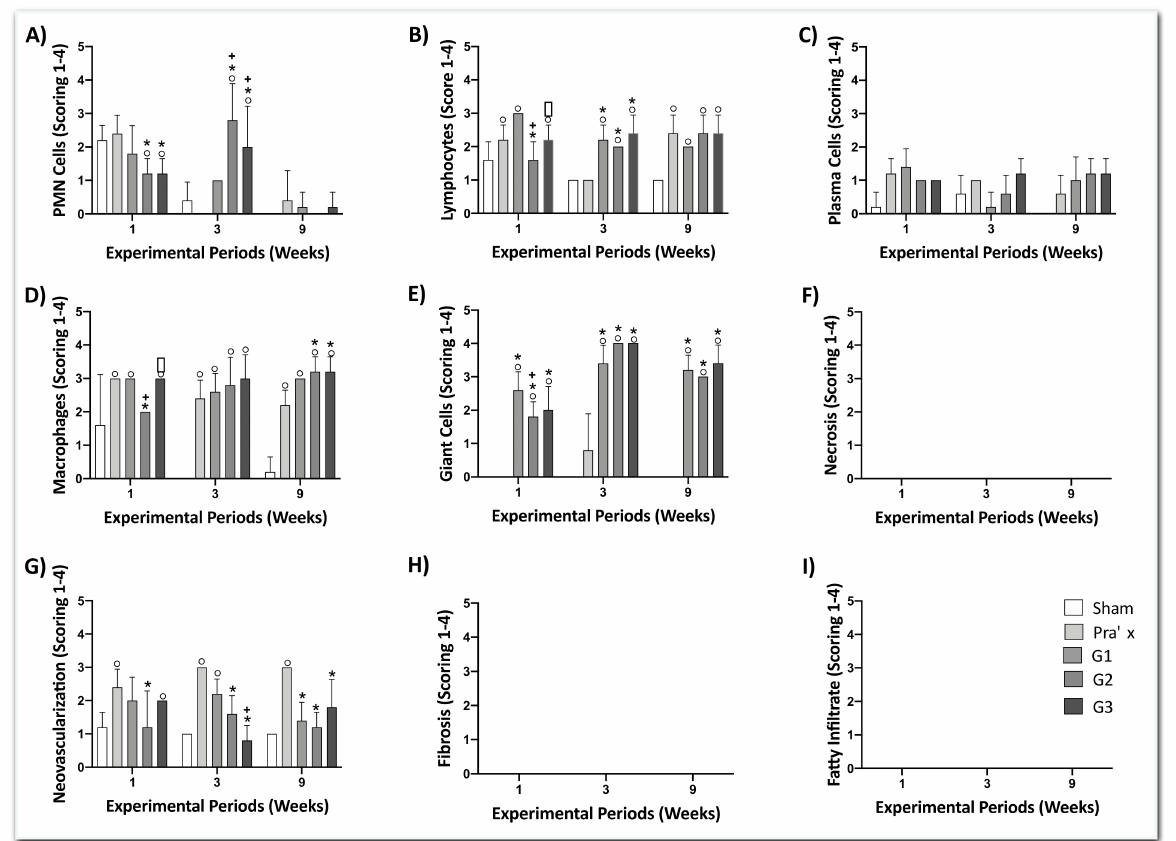
Figure 10. Inflammatory cells response ( A – E ) and overall tissue reaction ( F – I ) after experimental periods of 1, 3 and 9 weeks. Data ± standard deviation ( p < 0.05). Sham group was considered an experimental control. ( ◦ ) represents significantly difference when compared to the Sham group at same experimental period; (*) represents significantly difference when compared to the Pratix group at same experimental period; (+) represents significantly difference when compared to the G1 group at same experimental period; (*) represents significantly difference when compared to the G2 group at same experimental